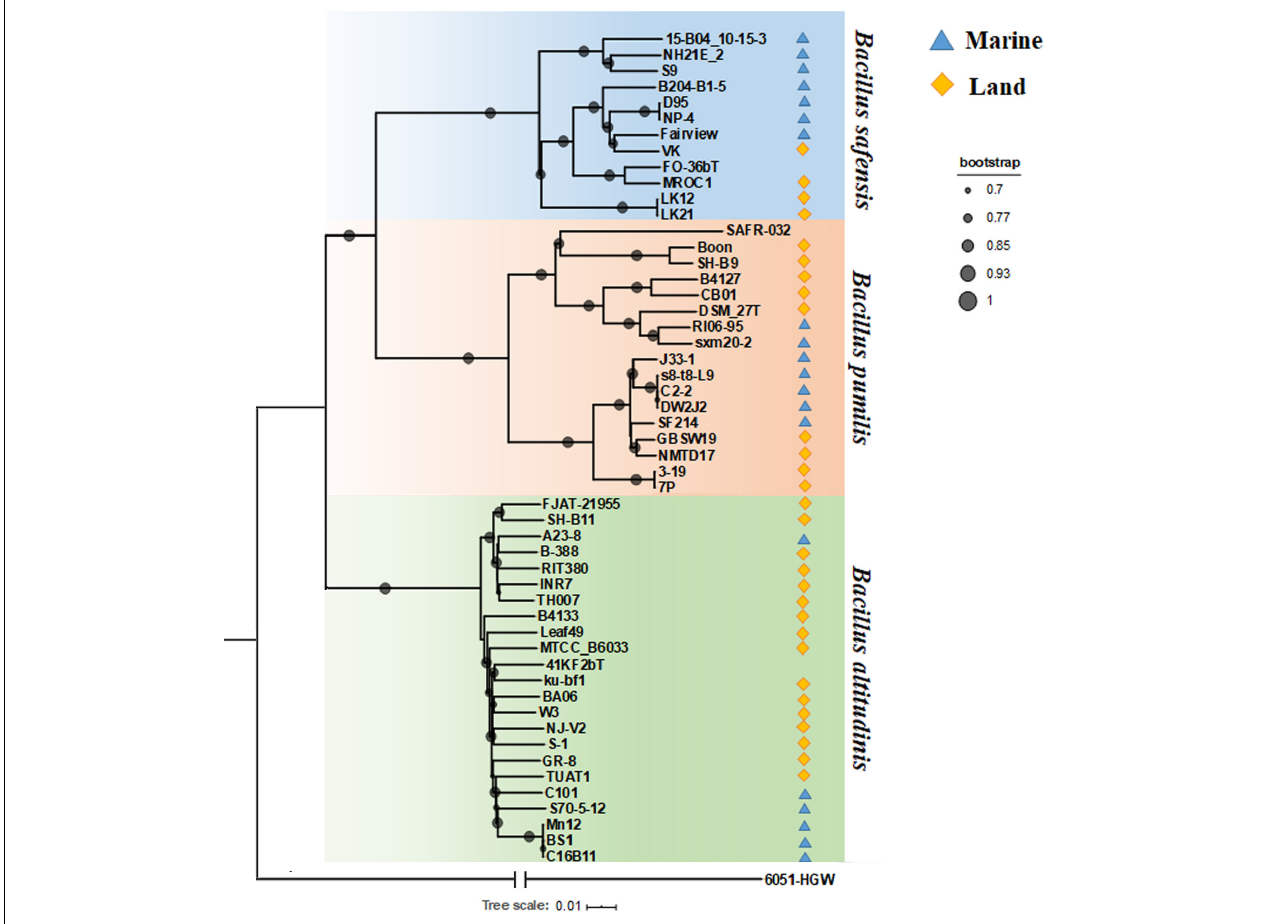
FIGURE 1 | Phylogenetic tree based on total single-copy orthologous. Different colored shading represents the different isolation environments of the strains. Blue represents marine, and yellow represents land environment.